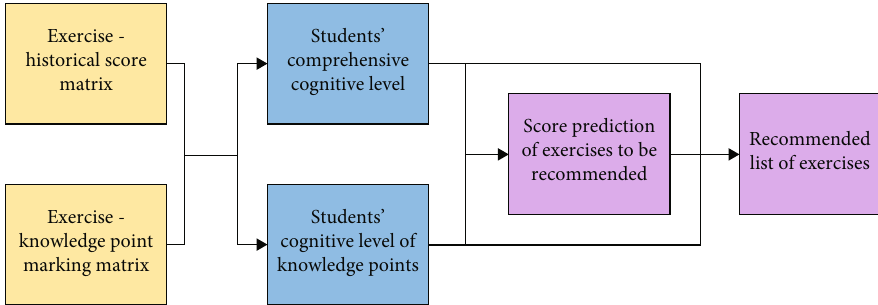
Figure 1: Flowchart of exercise recommendation algorithm based on learners ’ cognitive level.